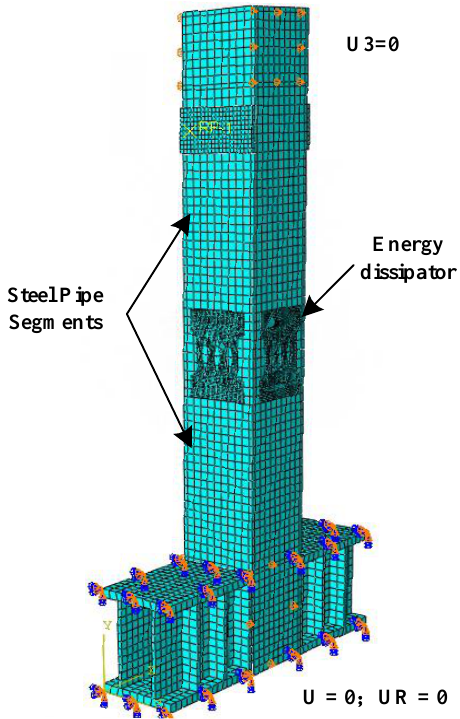
Figure 6. Finite element model of CFST pier.